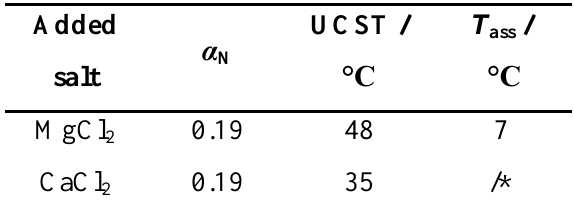
Table S7. UCST and T obtained from UV spectra of iPMA ( c ass and CaCl with I = 0.01 mol L -1 . 2